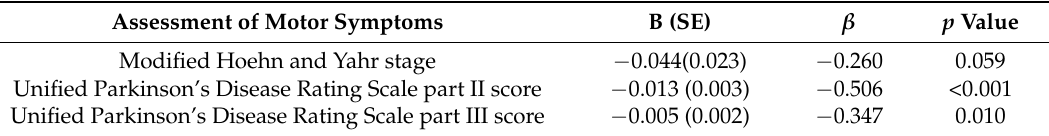
Table 2. Association of the amount of overall movement measured by MIMAMORI-Gait with the modified Hoehn and Yahr stage and UPDRS scores based on models adjusted for age, sex, and disease